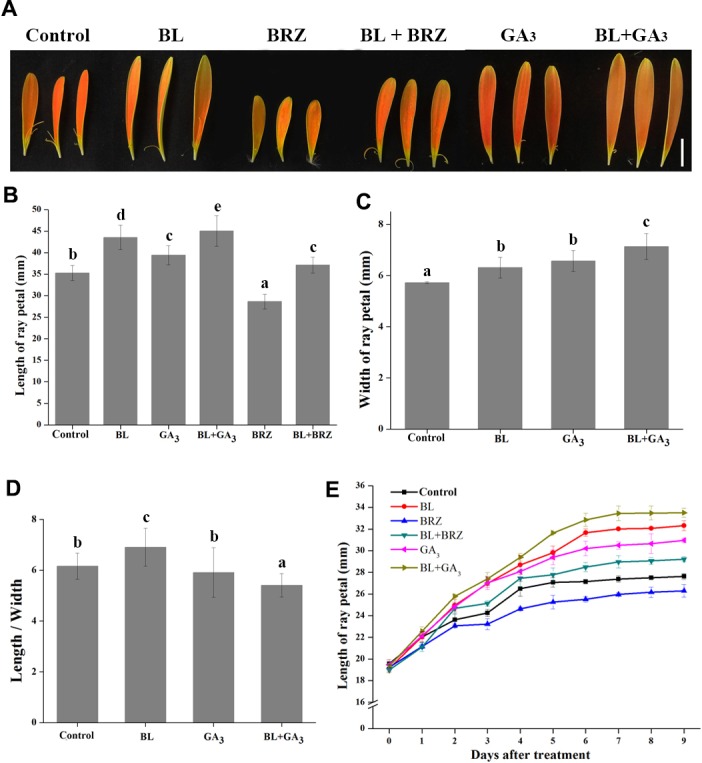
The effects of BRs and GAs on petal growth in G. hybrida.G. hybrida grew in a greenhouse under the conditions described in ‘Materials and Methods’. Plants with inflorescences at stage 2 were sprayed with deionized water (with 0.1% ethanol) (Control), 10 µM BL, 10 µM GA3, 10µM BRZ, a mixture of 10 µM BL and 10 µM GA3 (BL + GA3), or a mixture of 10 µM BL and 10 µM BRZ (BL + BRZ) and were subjected to morphological characterization (A), then the petal length (B), width (C) and length/width (D) were measured and calculated after nine days of treatment. Five to six inflorescences were measured for each treatment (Scale bar represents 1 cm. Value = means ± SE, n > 10, letters above the bars indicate significant differences between the respective values (p < 0.05)). (E) Time-course dynamics of petal length under different treatments. Detached petals were used in this experiment, at least 10 petals for each treatment were cultured for nine days.